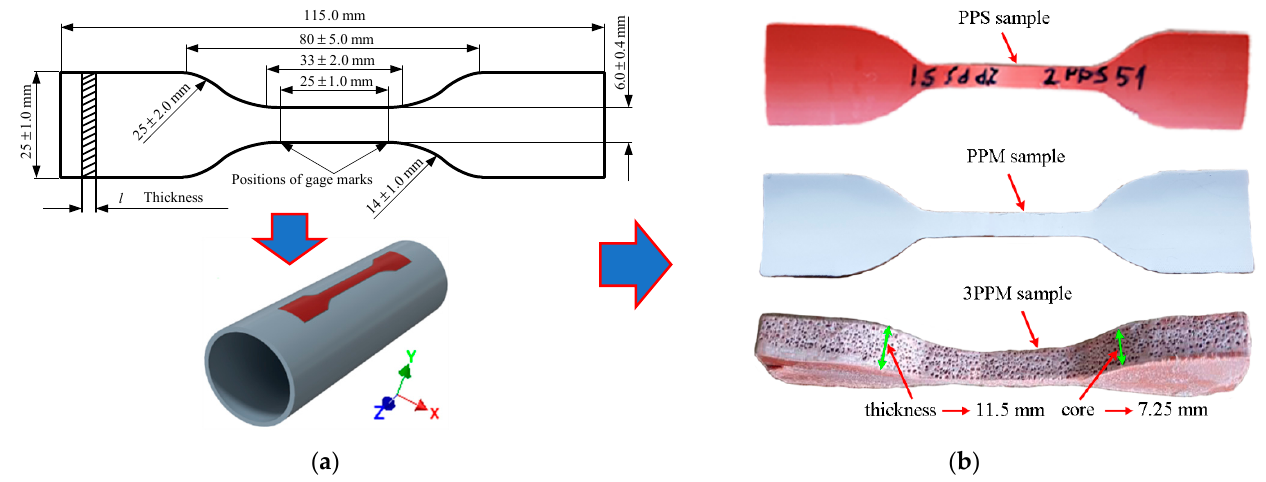
Figure 2. Preparation of tensile test specimens from pipes: ( a ) cutting technology of samples from pipes; ( b ) geometry of the samples tested.